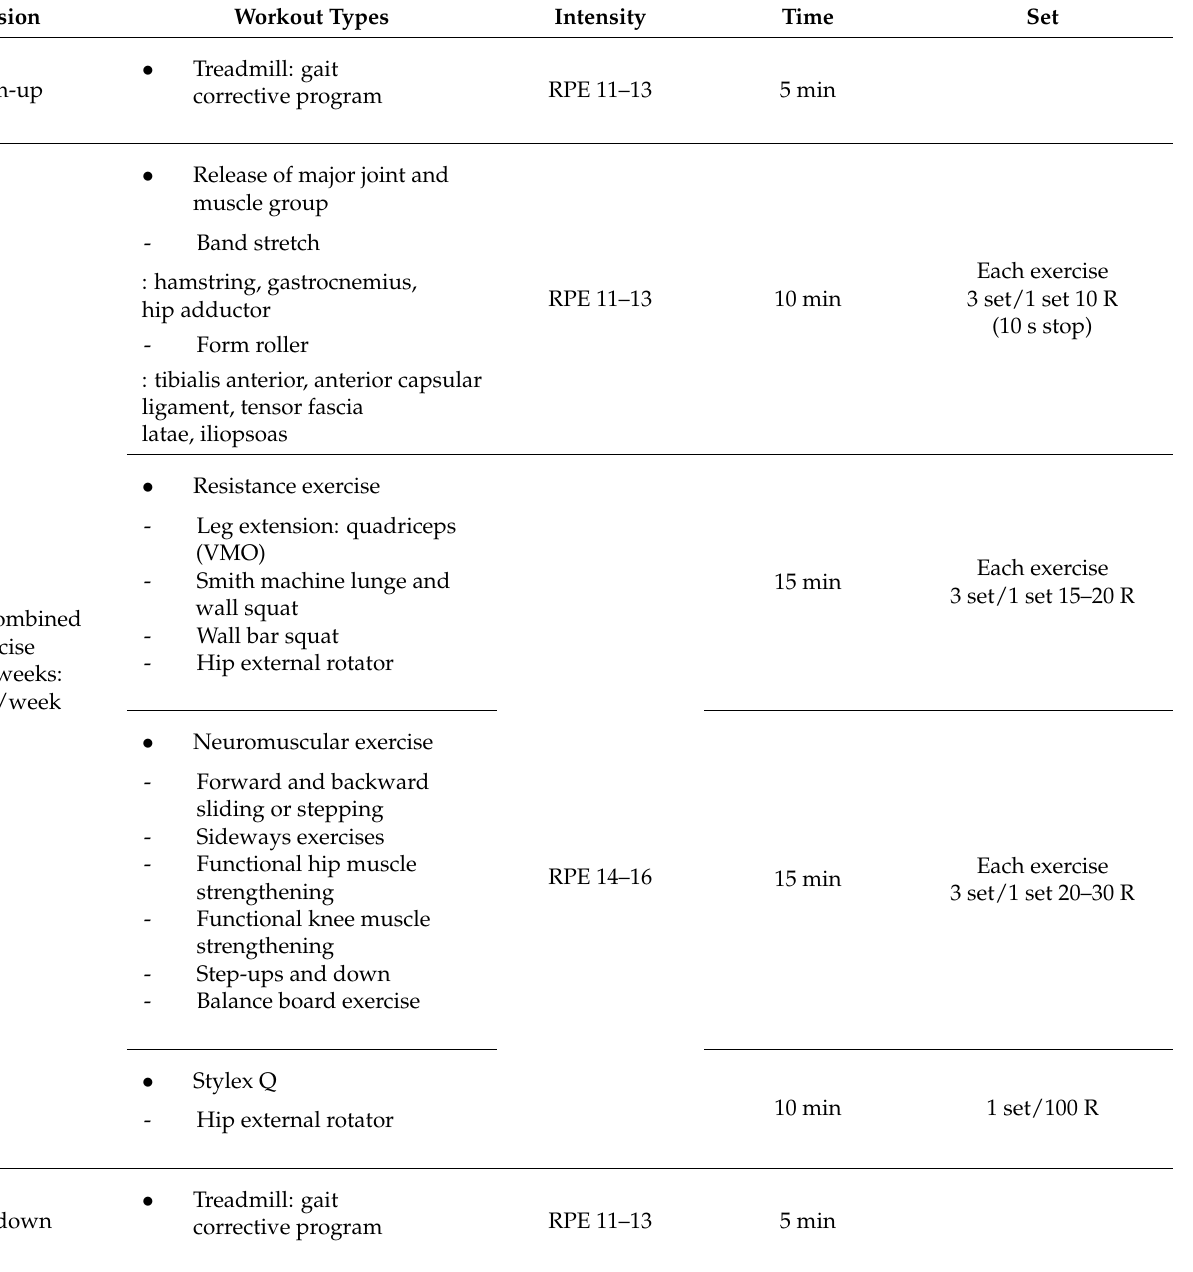
Table 2. Combined exercise